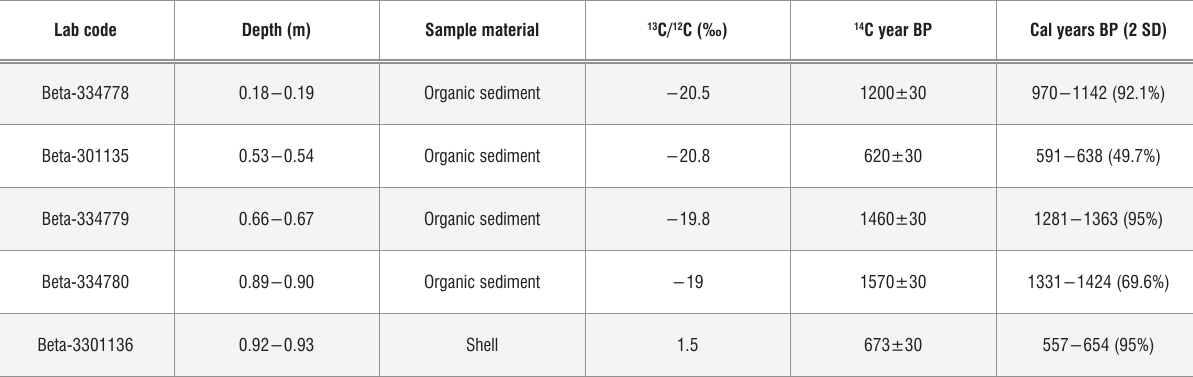
Radiocarbon dating results for the Kariega record, indicating calibrated and uncalibrated ages